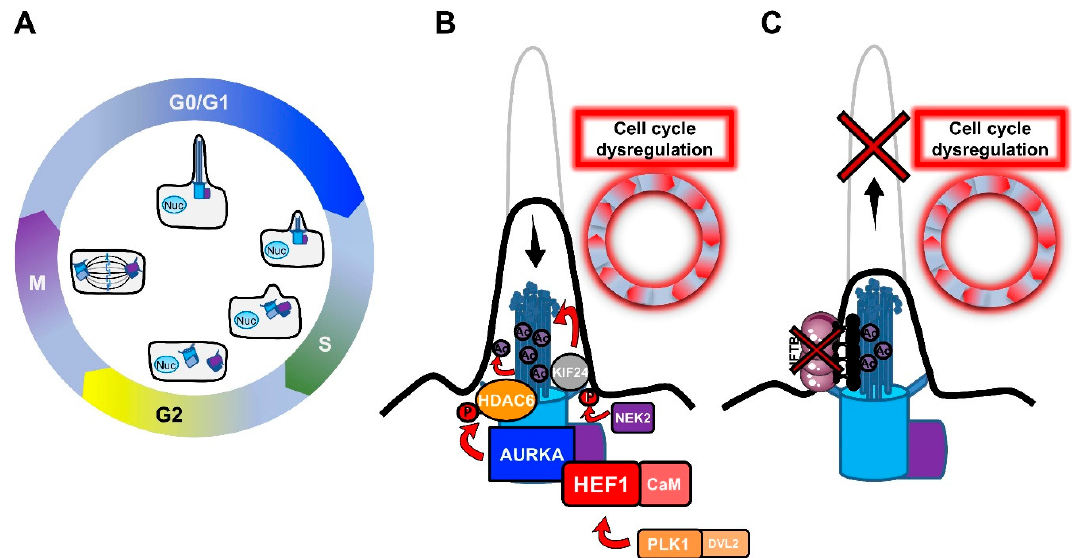
Figure 1. Regulation of ciliogenesis and cell cycle. ( A ) Primary cilium formation occurs during the G0/G1 phase. Upon entry into S phase, the DNA, and the mother and daughter centrioles (blue and purple boxes respectively) initiate replication, and two newly centrioles are formed. Before mitosis, the new pair of centrioles migrate to the opposite pole of the cell, and the daughter centriole matures into a new mother centriole. Ciliary disassembly takes place at the G2/M transition. After mitosis, each daughter cell inherits a pair of centrioles, and the cilia reassemble in the next G0/G1 phase. ( B ) Cell cycle regulators AURKA, PLK1, and NEK2 participate in cilium disassembly, thus impairing the cell cycle. This may explain the involvement of these factors in cancer progression. HEF1/CaM binds to AURKA, promoting its activation. AURKA in turn phosphorylates and activates HDAC6, resulting in HDAC6 mediated deacetylation of substrates in the ciliary axoneme, causing ciliary resorption. PLK1/DVL2 can also activate HEF1, and NEK2 phosphorylates KIF24, which promotes microtubule disassembly. ( C ) The disruption of the anterograde IFTB subcomplex and/or the kinesin molecular motor leads to defects in the cilium assembly, thus promoting cell cycle defects and cell proliferation. Ac: Acetylation; AURKA: Aurora A Kinase; CaM: Calmodulin; DVL2: Dishevelled